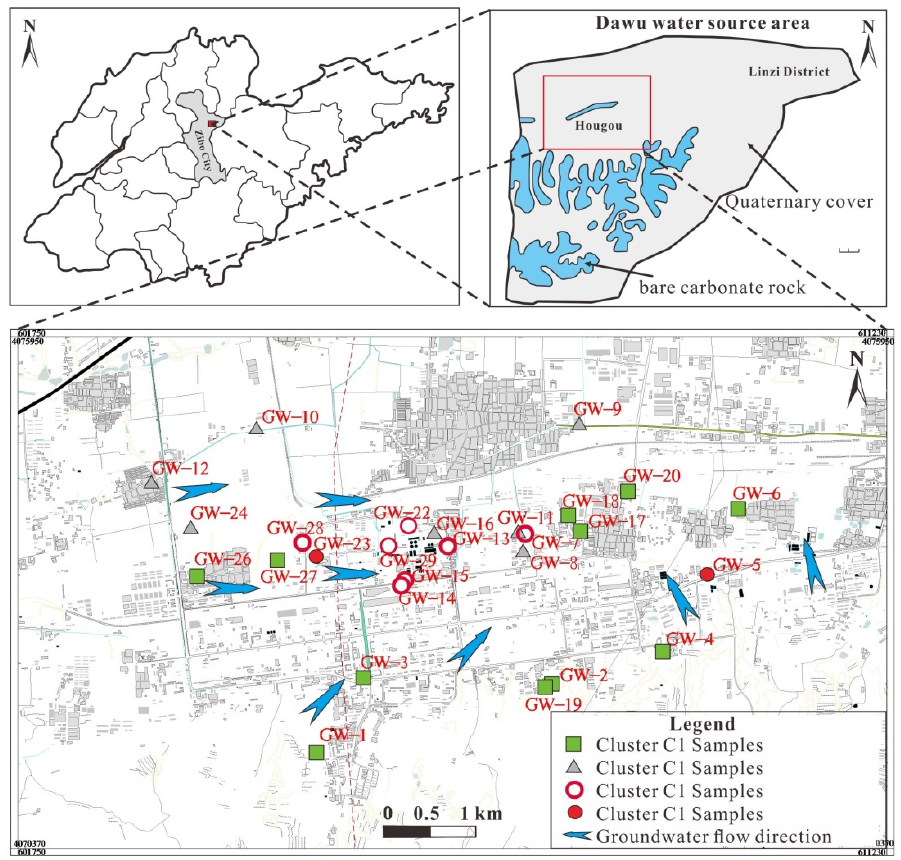
Figure 1. Spatial distribution of groundwater samples with different cluster types.